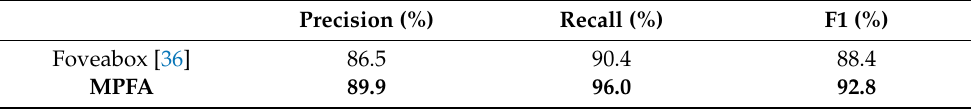
Table 7. Performance of a more precise foveal area in RSI.